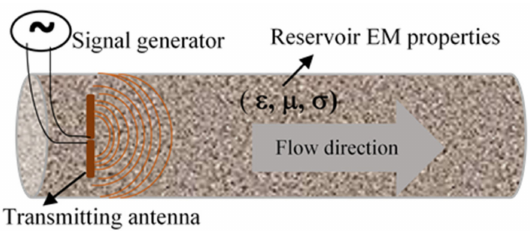
Figure 2. Schematic diagram of reservoir geometry with electromagnetic (EM) simulation.